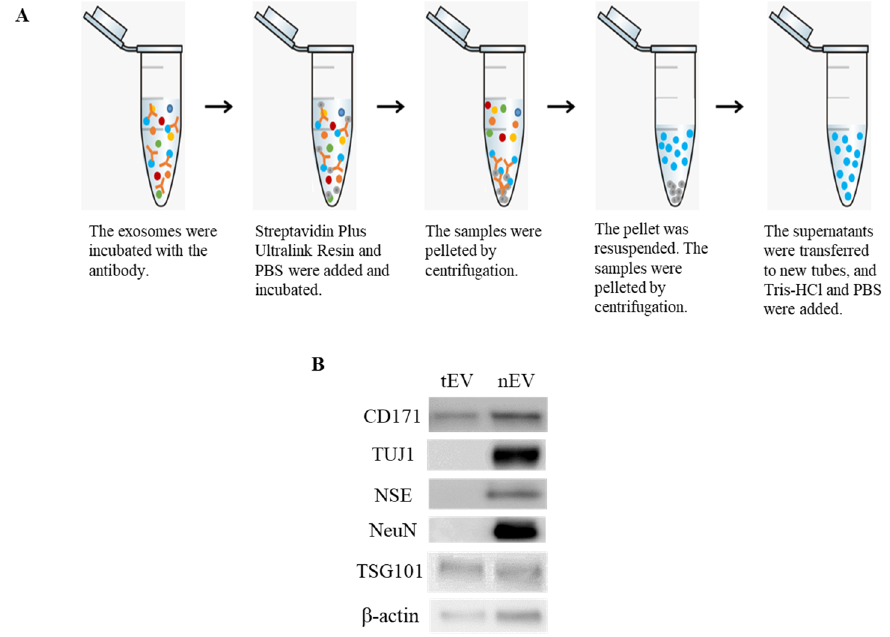
Figure 5. Isolation and characterization of neuronal exosomes (nEVs) in serum: ( A ) Protocol for the isolation of nEVs; ( B ) Western blot images showing the enrichment of nEV-associated markers (nEV marker: CD171; neuronal markers: neuron-specific class III beta-tubulin (TUJ1), neuron-specific enolase (NSE), and neuronal nuclei (NeuN); exosome marker: tumor susceptibility gene 101 (TSG101)).